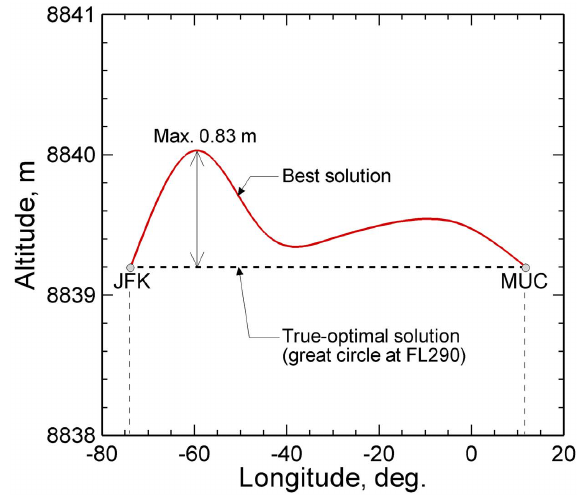
Figure 9. Trajectories for the best solution (red line) and the true- optimal solution (dashed line, black). This shows the enlarged draw- ing of Fig. 8 (top). The maximum difference in altitude is 0.83m.